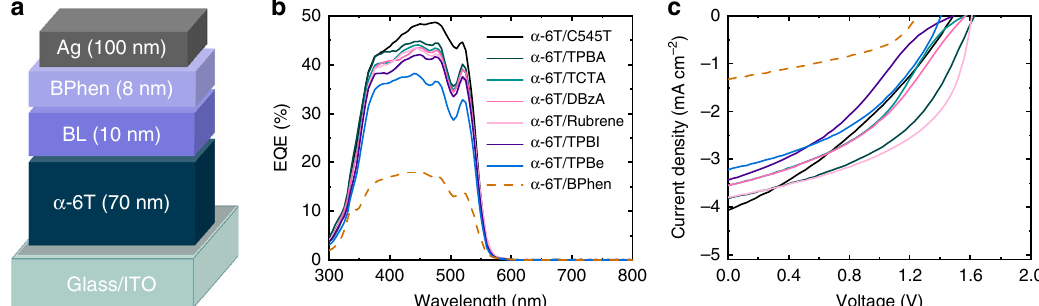
Fig. 1 Organic solar cells based on α -6T and various buffer layers. a Device architecture of the investigated devices. BPhen and an additional buffer layer (BL) are used between α -6T and the top contact (Ag). The numbers in the parentheses denote the layer thickness in nanometre. b External quantum ef fi ciency (EQE) spectra and c current – voltage characteristic curves of solar cells employing α -6T and various BL